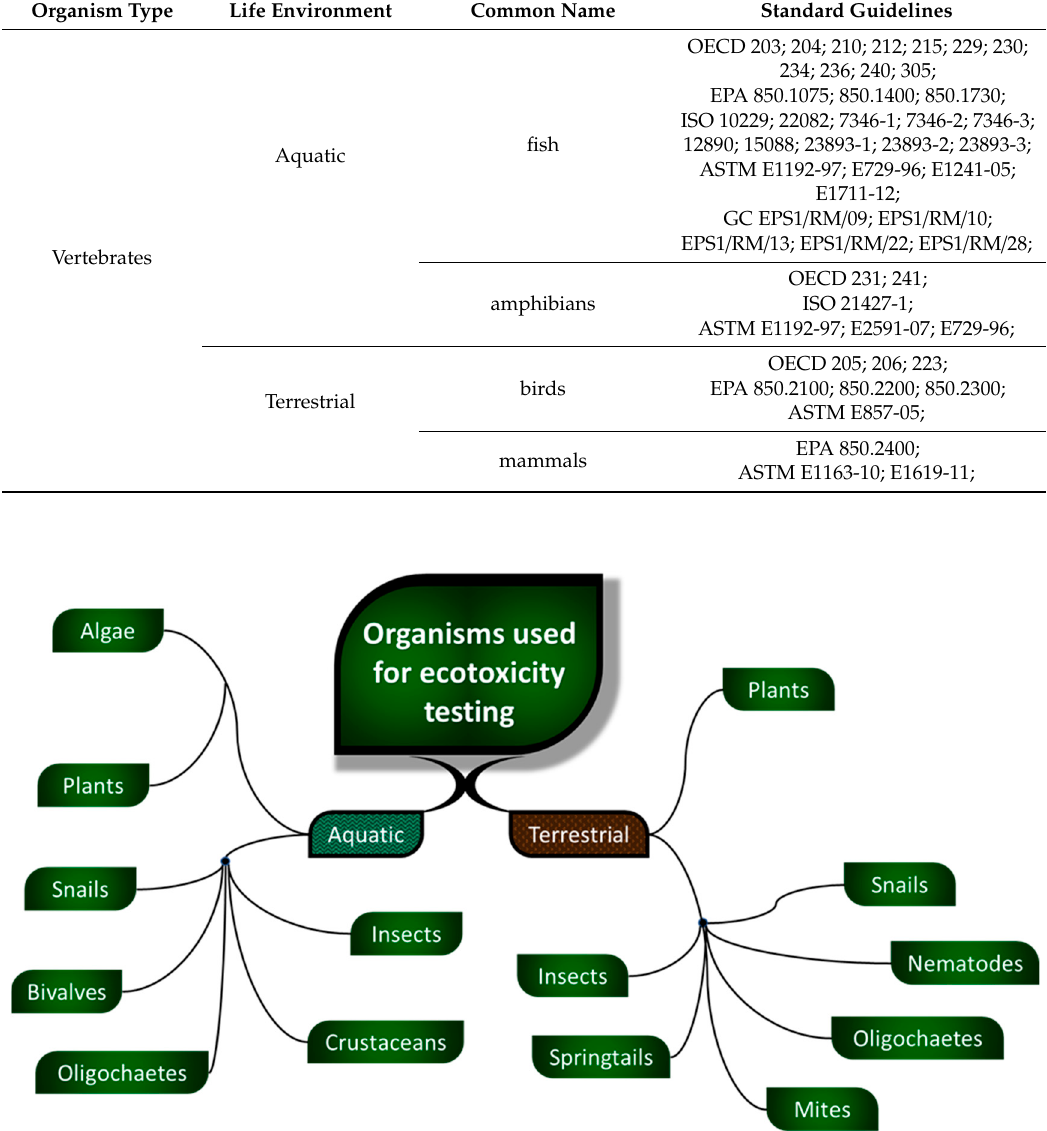
Figure 4. Categories of organisms that are used in standard guidelines for ecotoxicity assessment, several of the mentioned organisms being suitable for simple and rapid ecotoxicity testing (SSRET).